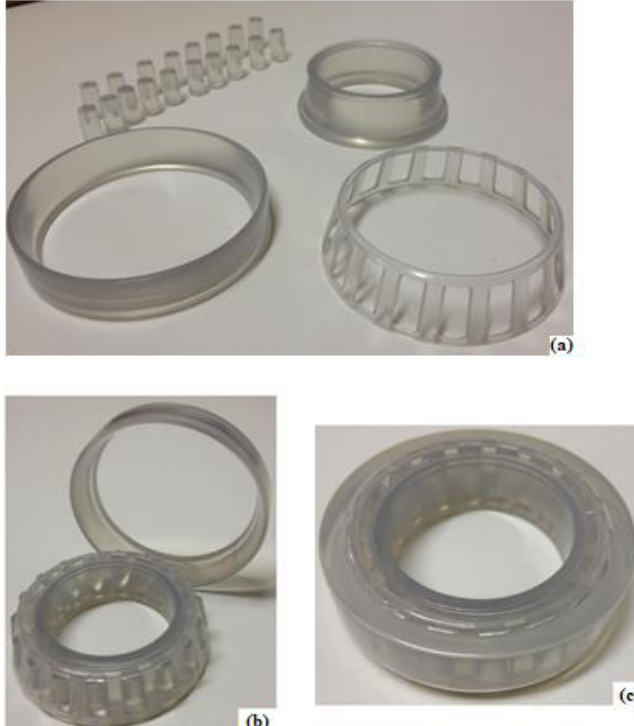
Figure 1. ( a ) Sample of tapered roller bearing made in stereolithography (SLA)-separate components. Sample of tapered roller bearing made in stereolithography (SLA): ( b ) separate outer ring, and ( c ) mounted bearing.